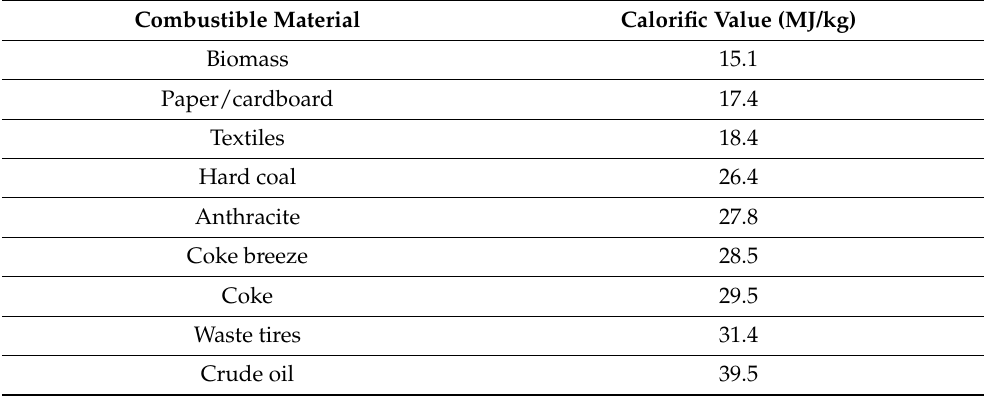
Table 1. Comparison of calorific values of selected combustible materials